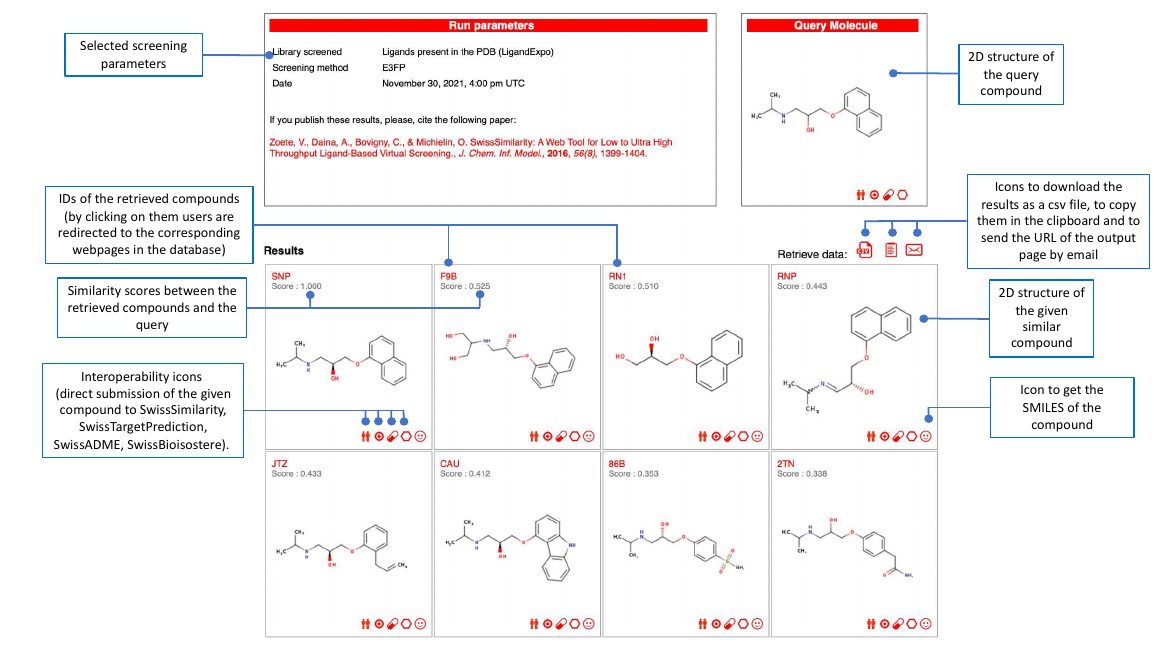
Figure 3. Example of an output page to analyze the most similar molecules to the query by, e.g., accessing the database of origin, or submitting a given compound to other SwissDrugDesign tools through the interoperability icons.